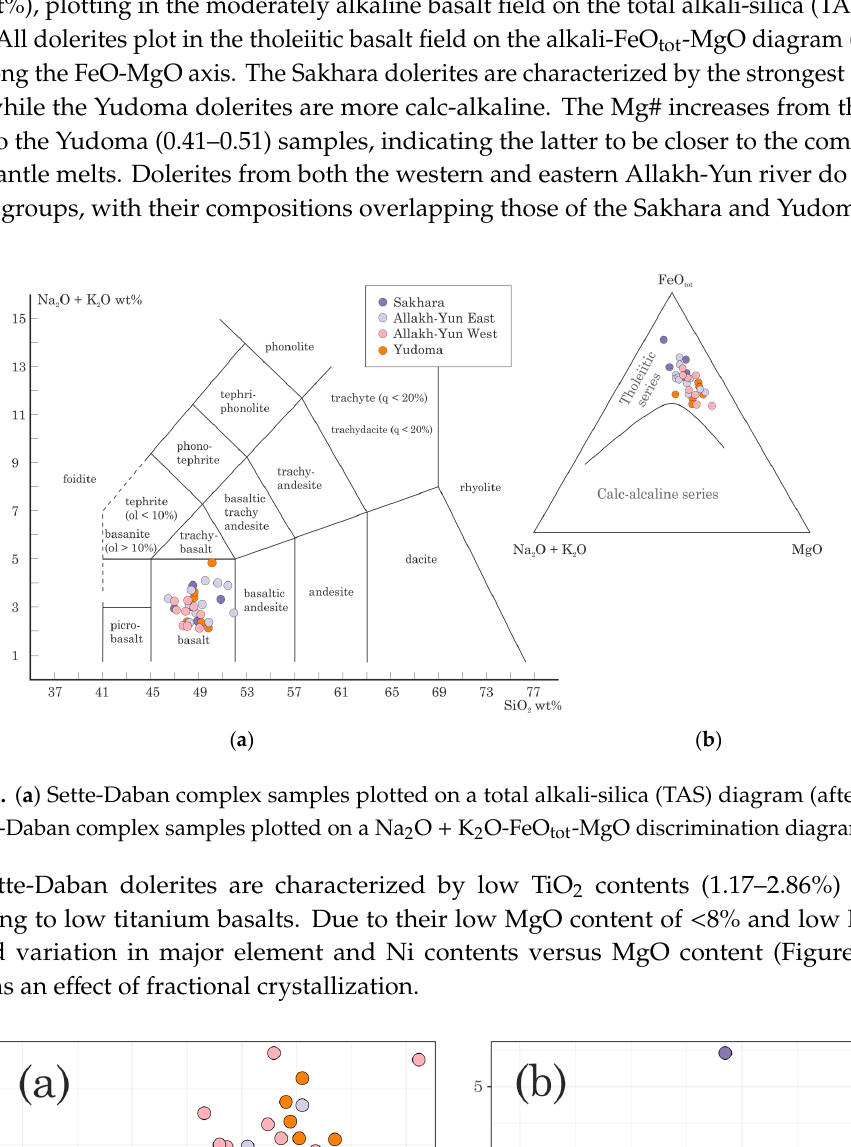
Figure 5. Plots of ( a ) CaO (wt%), ( b ) TiO 2 (wt%), ( c ) FeO tot (wt%), and ( d ) Ni (ppm) vs. MgO (wt%) for the Sette-Daban event dolerites. 4.2. REE and Other Incompatible Elements Major element compositions in a residual melt evolve as the crystallization of minerals such as plagioclase, olivine, or pyroxene takes place, hampering an interpretation of the original source of the melt based on major element compositions alone. However, the concentrations of highly incompatible large ion lithophile elements (LILE) and high field strength elements (HFSE), including rare earth elements (REE), are much less affected by fractional crystallization. Moreover, ratios of highly incompatible LILE are unaffected by fractional crystallization, with ratios primarily controlled by the degree of partial melting [24]. Therefore, in order to constrain the partial melting process of the mantle source, we focus on ratios of highly incompatible LILE in the discussion below. Samples from the Sakhara and eastern Allakh-Yun rivers show an enrichment in light rare earth elements (LREE) over heavy rare earth elements (HREE) [(La/Yb) N = 1.58–3.35] and weak Eu depletion (Figure 6a). Primitive mantle- (PM-) normalized trace element patterns (Figure 6b) of the Sakhara and eastern Allakh-Yun dolerites exhibit some variations in LILE and a generally pronounced